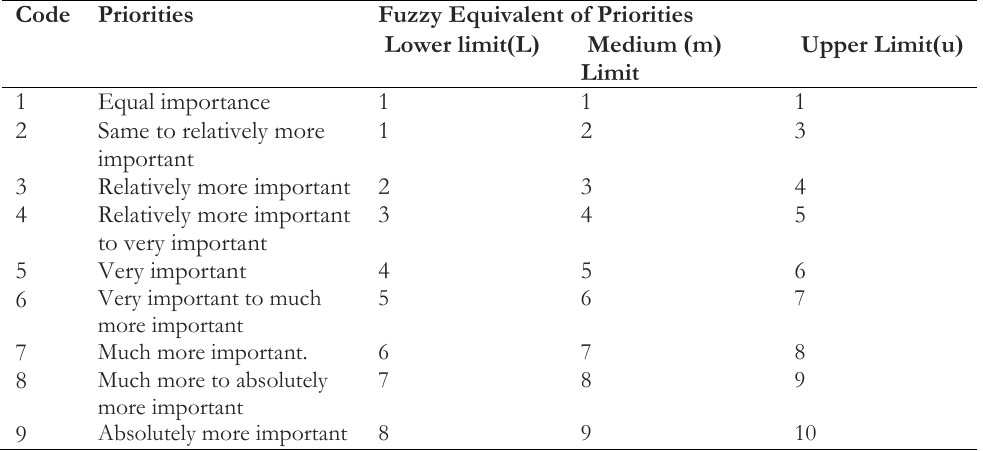
Table 2. Linguistic terms and corresponding fuzzy